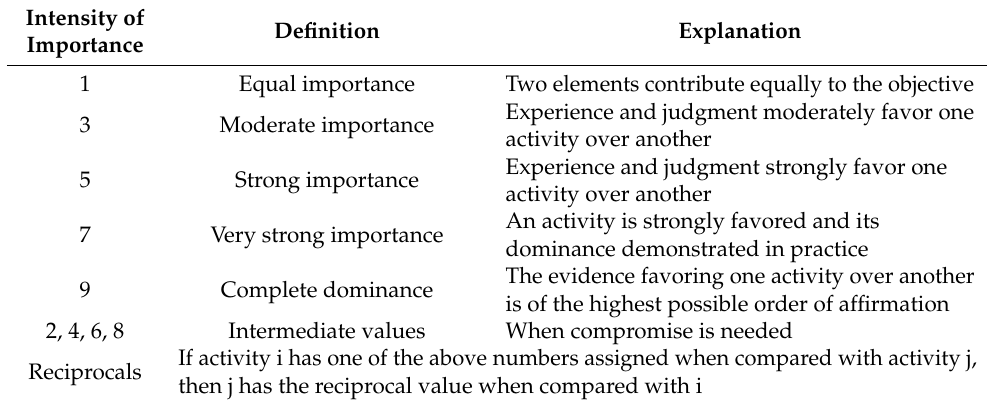
Table 1. The Fundamental Scale for Pairwise